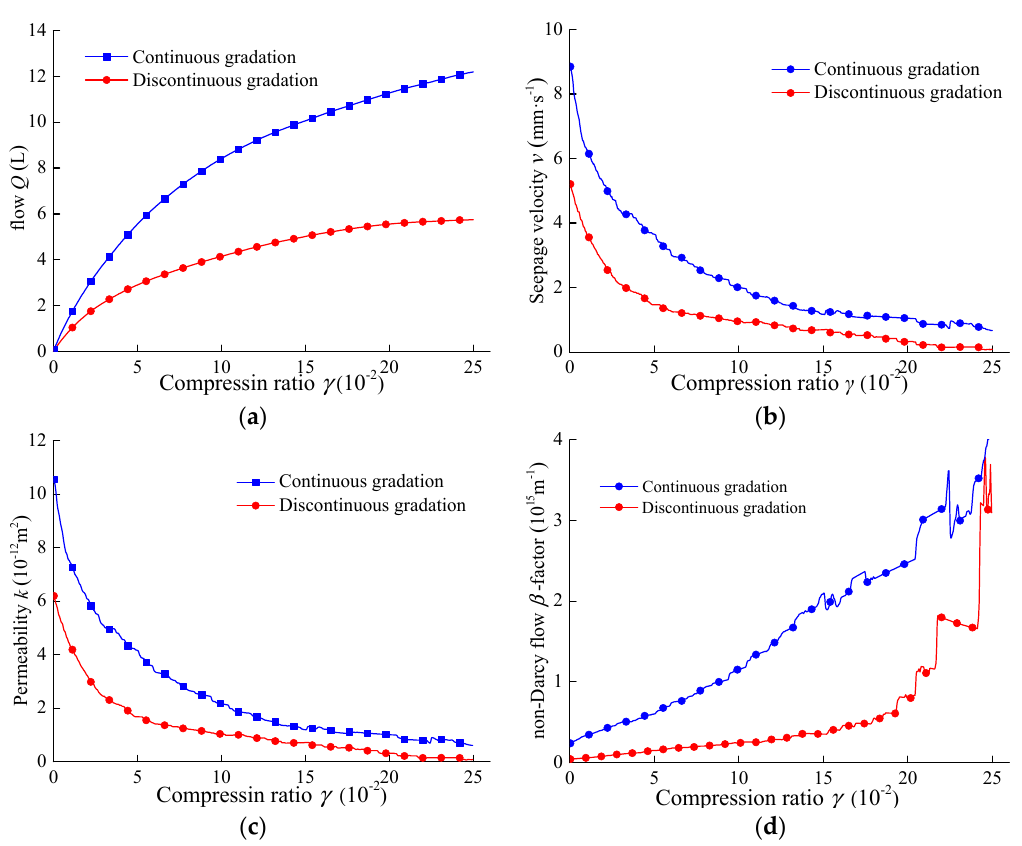
Figure 5. Evolution law of seepage characteristic of broken gangue under compression condition: ( a ) evolution law of cumulative flow; ( b ) evolution law of seepage velocity; ( c ) evolution law of permeability; and ( d ) evolution law of β -factor for non-Darcy flow.